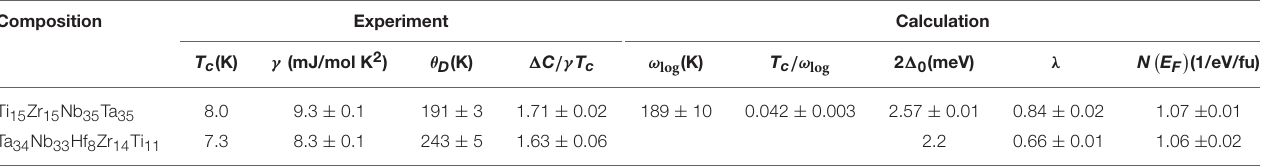
TABLE 2 | SC parameters of Ti 15 Zr 15 Nb 35 Ta 35 HEA and the reported Ta 34 Nb 33 Hf 8 Zr 14 Ti 11 HEA (Koželj et al., 2014).